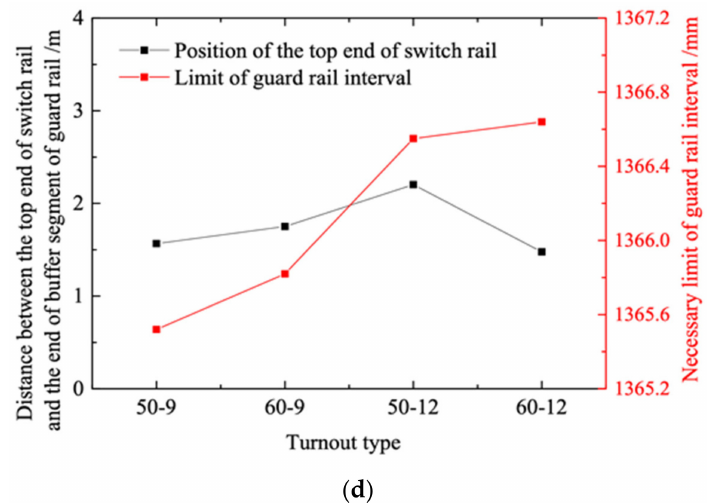
Figure 13. Effect of double-slip turnout alignment parameters on the limit of the guardrail interval. ( a ) Attack angle of the top end of the switch rail; ( b ) Gage widening; ( c ) Distance between the top end of the switch rail and the end of the buffer segment of the guardrail; ( d ) Distance between the end of gage widening and the end of the buffer segment of the guardrail.